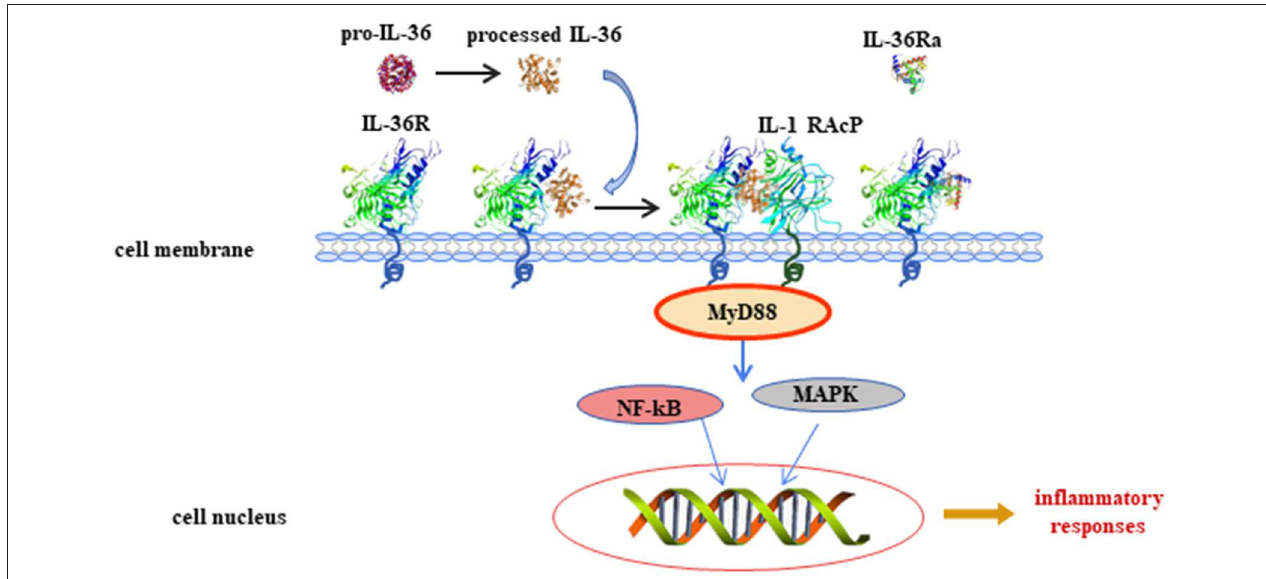
FIGURE 1 | Interleukin (IL)-36 signal pathways induce inflammatory responses. Pro-IL-36 cytokines are inactive proteins and require post-translational processing to fully unleash the pro-inflammatory activity. IL-36 agonists bind to heterodimeric receptor complexes, including IL-36 receptor (IL-36R) and co-receptor IL-1 receptor accessory protein (IL-1RAcP). Subsequently, the heterotrimer complex binds to adaptor protein myeloid differentiated protein 88 (MyD88), activating mitogen-activated protein kinase (MAPK) and nuclear transcription factor kappa B (NF- κ B) signaling cascade pathways, and regulates expression of target genes.